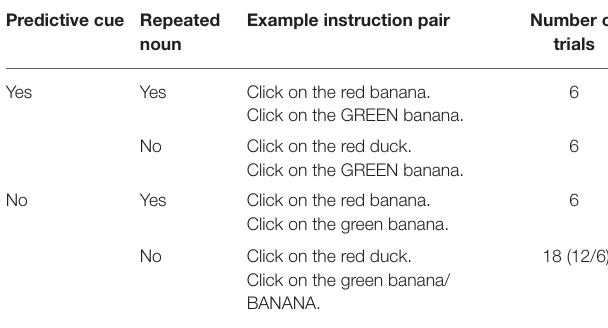
TABLE 1 | Relevant conditions for the current analyses. The second sentence in each instruction pair is the target sentence. Predictive cue Repeated Example instruction noun